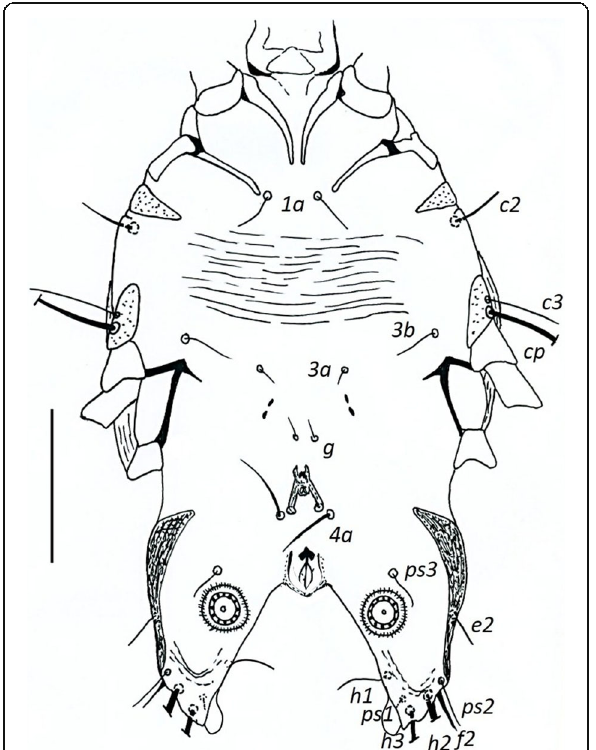
Fig. 2 Gabucinia delibata (Robin), male venter (scale bar, 100 μ